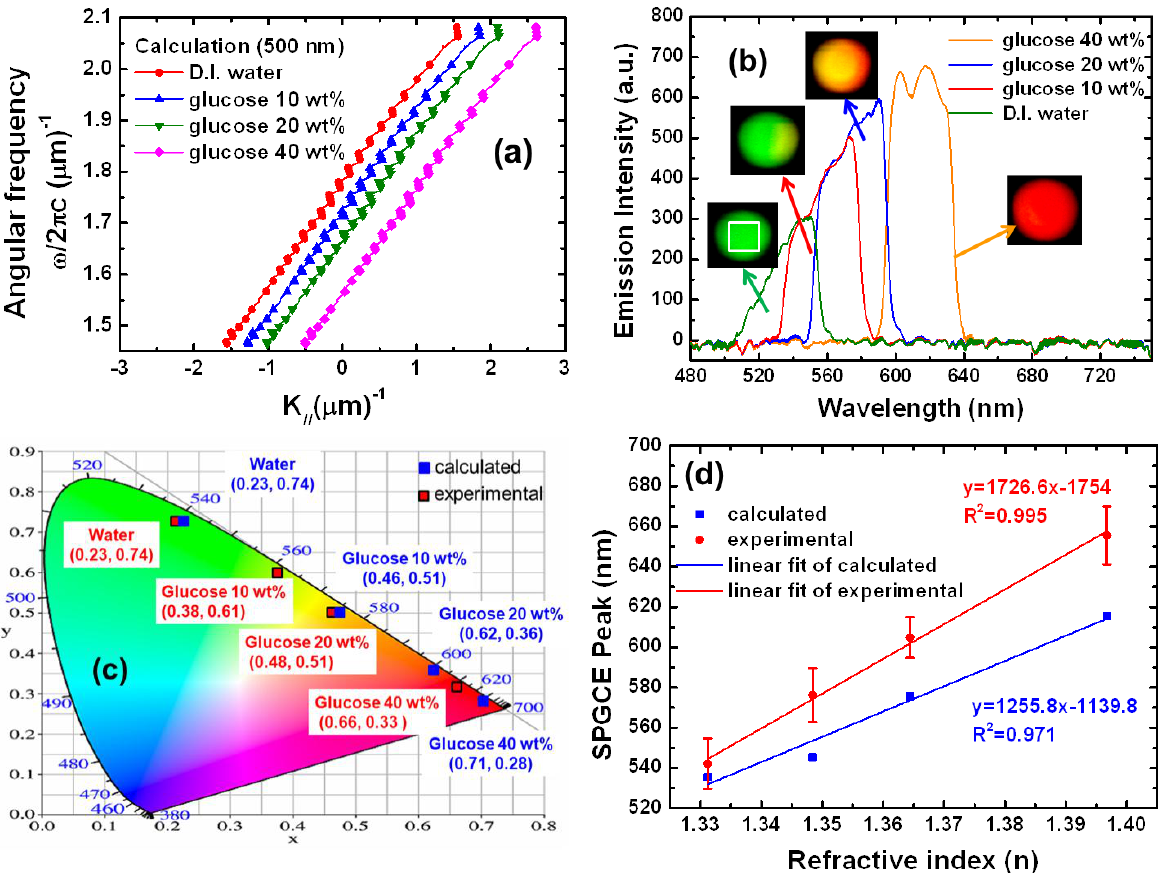
Figure 4. Experimental and calculation results for pitch size of 500 nm. ( a ) Dispersion relation calculated for different species contacting the top side of the sample; ( b ) experimental results showing the SPGCE sensor at difference dielectrics of the sample; ( c ) shift in experimental and calculated CIE coordinates for different species at a fixed viewing angle; and ( d ) the calibration curve for the determination of D.I. water and in 10 wt%, 20 wt%, and 40 wt% glucose solutions for the